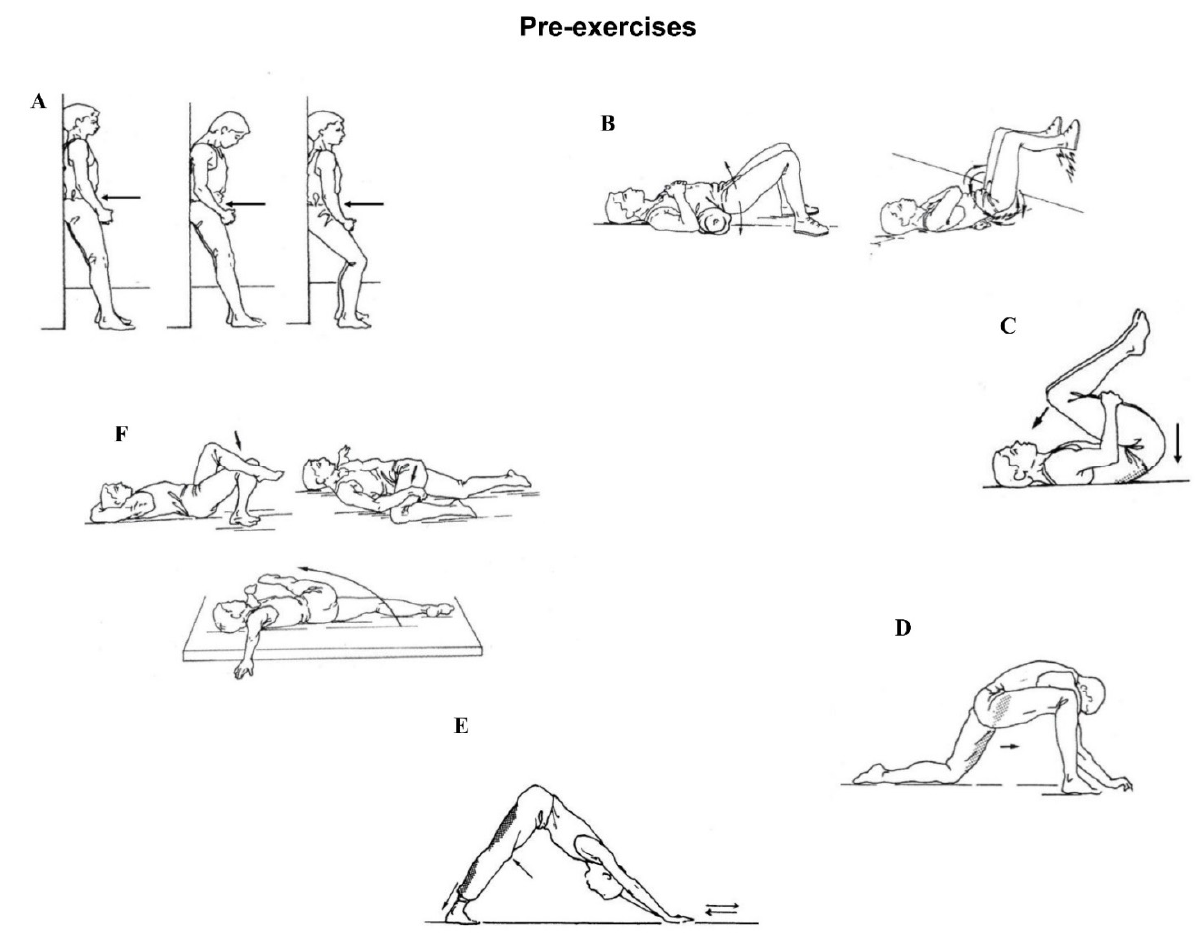
Figure 2. Pre-exercises that were performed prior to the testing procedure. ( A ): Pelvic tilting in upright position by flattening back and sliding up and down against a wall, to initiate the concept of proper bending and squatting. ( B ): Gentle rotation and elevation of the pelvis forward and backward. Feet on the floor and wall. ( C ): Both knees towards the chest into a fully flexed position, the lumbar spine pressed to the floor. ( D ): Stretching the iliopsoas muscle. ( E ): Stretching the ham- strings and gastrocnemii muscles. ( F ): Stretching the obliqui and muscles around the